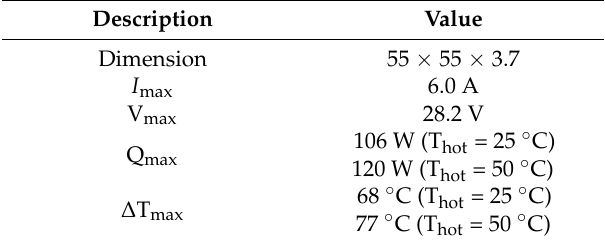
Table 1. The characteristics of the thermoelectric module (TEM) [18].